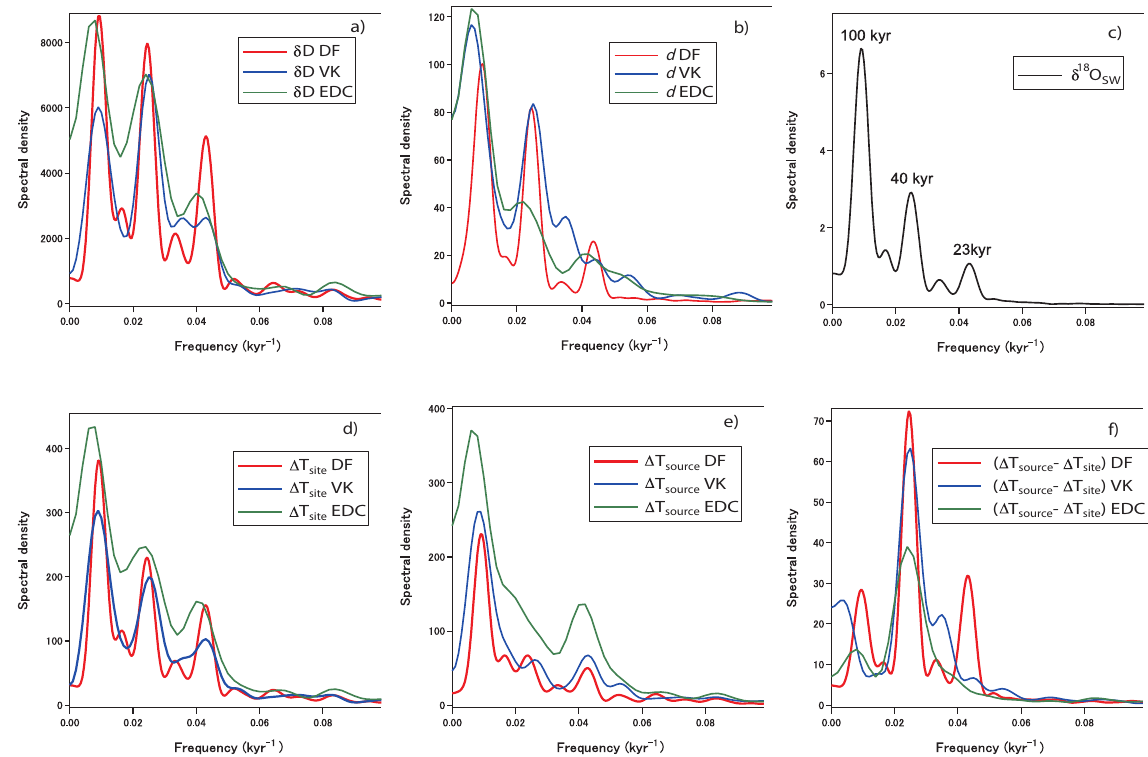
Fig. 9. Power spectra of DF core isotope records. Power spectra of DF (red), Vostok (blue), and EDC (green); (a) δ D, (b) d , (c) Ocean isotope change ( δ 18 O sw ) over the past 360kyr (Bintanja and Wal, 2008), (d) 1T site , (e) 1T source , and (f) temperature gradient ( 1T source − 1T site ) . Spectral analysis is performed using Blackman-Tukey analysis with 50% of series lag (for DF, Vostok, and δ 18 O sw ) and 70% (for EDC) with the Analyseries software (Paillard et al.,